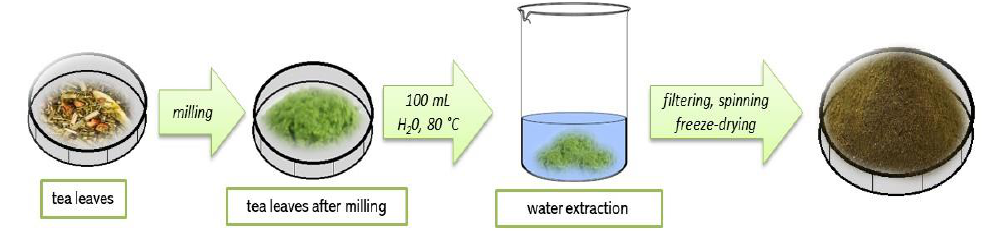
Figure 1. The scheme of the preparation of tea lyophilizate.